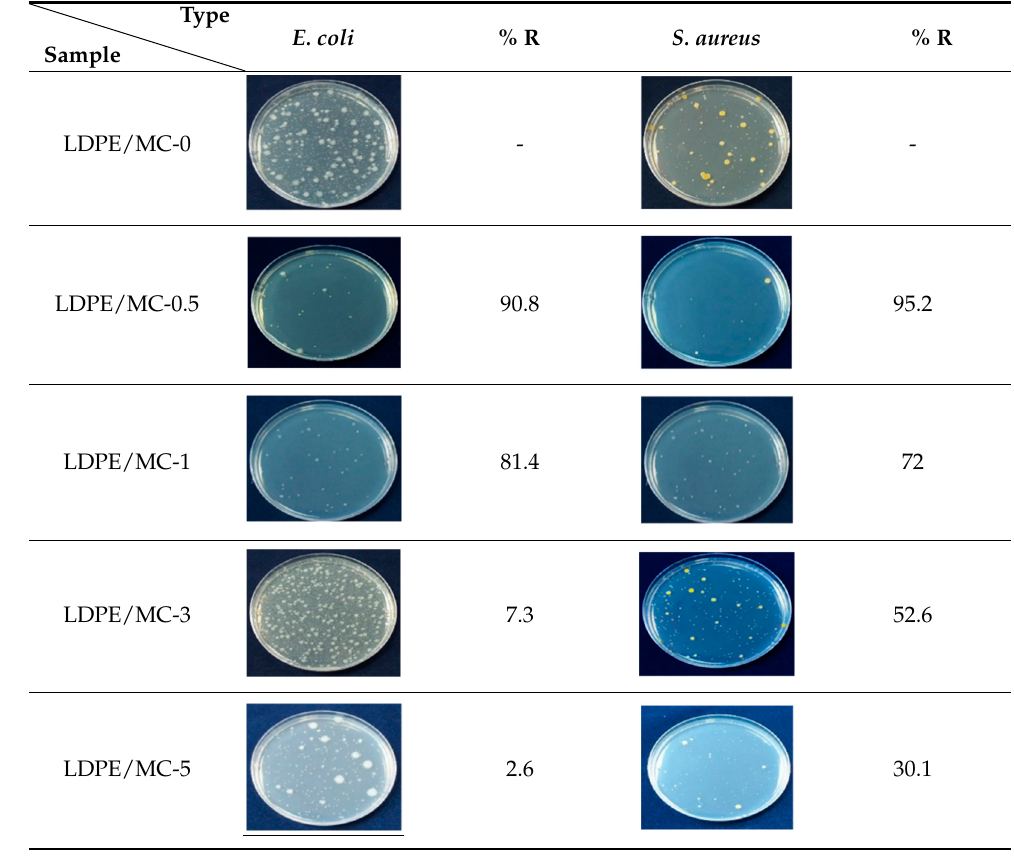
Table 2. Antimicrobial Activities of LDPE/MC Composite Films.